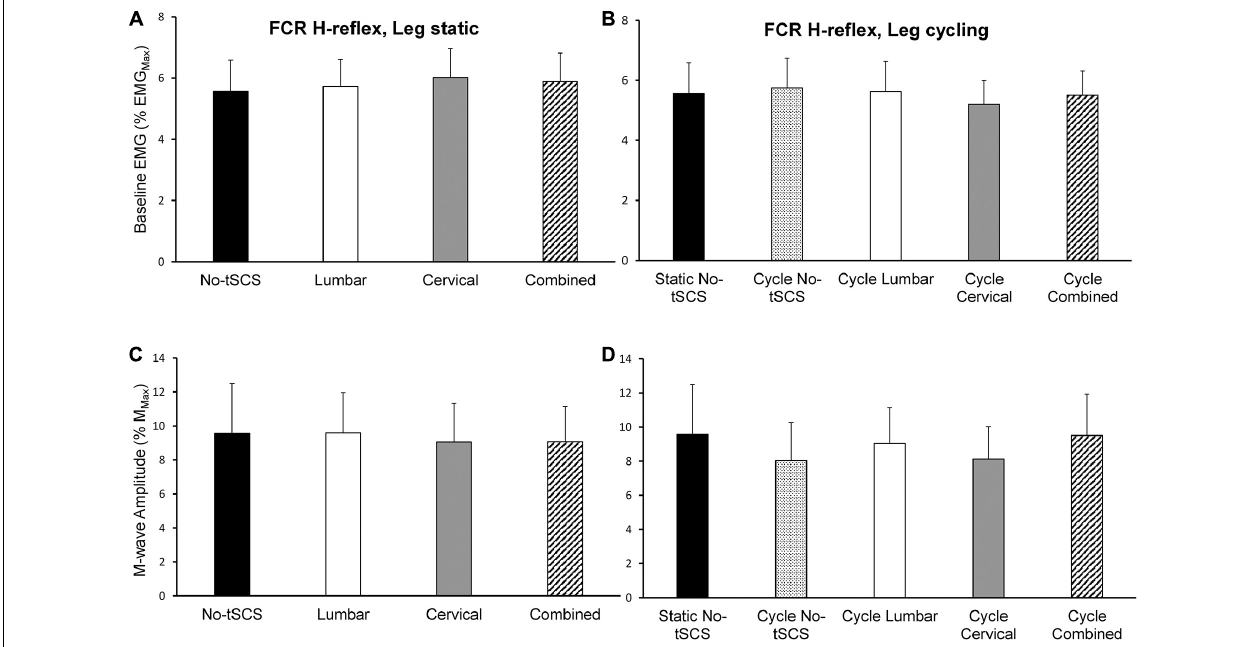
FIGURE 6 | Baseline FCR muscle activity and M-wave amplitude during H-reflex assessments. The average baseline activity in the FCR muscle during H-reflex assessment (normalized to the maximal EMG activity during MVC) while the legs were (A) static and (B) cycling was similar indicating that a consistent contraction was held across all experimental conditions. The average peak-to-peak amplitude of the FCR M-wave was similar across all (C) static and (D) cycling conditions indicating that a similar direct motor response was evoked by the median nerve stimulus across all experimental conditions. Values are Mean ±